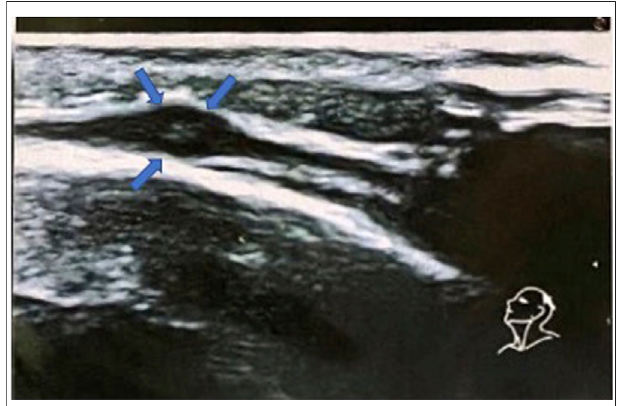
FIGURE 3 | Ultrasound images of scalp nodules showing fi brotic and granulomatous